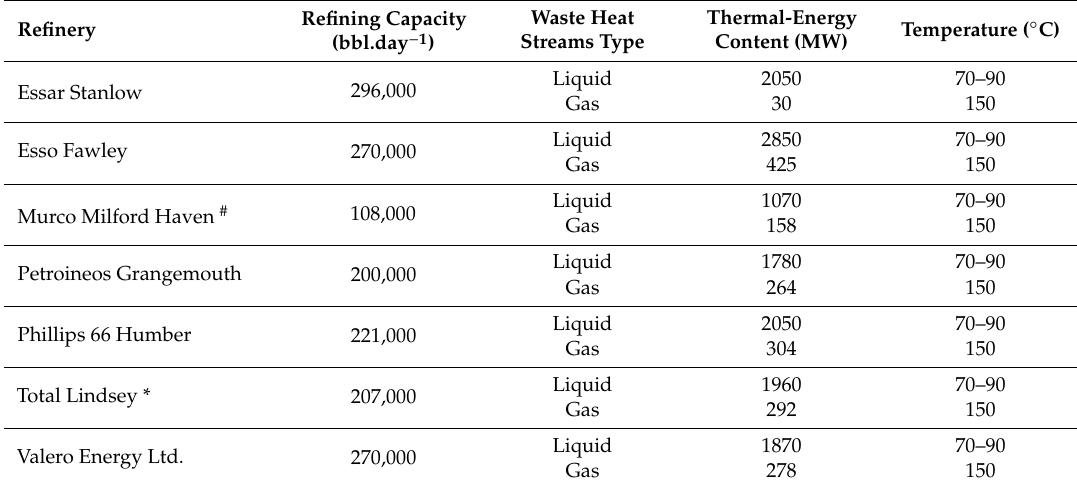
Table 3. Estimates of low-grade heat sources in the UK oil refining industry